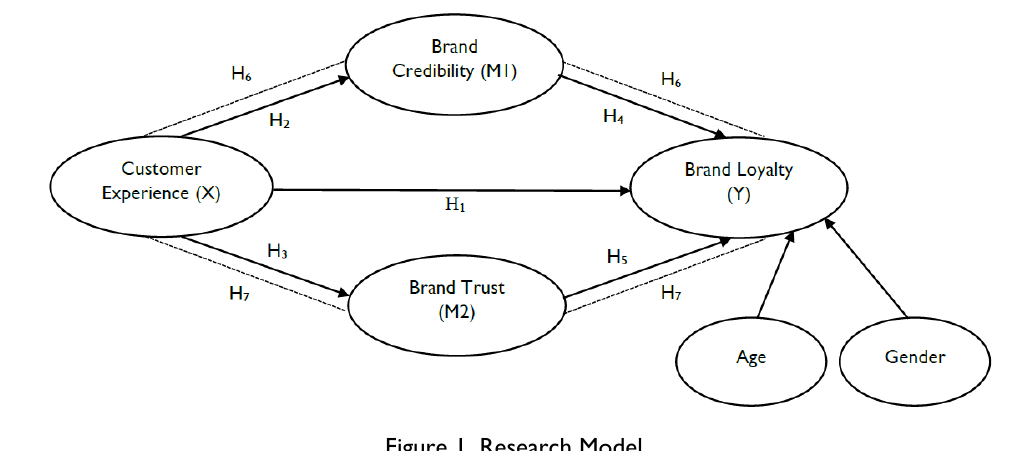
Figure 1. Research